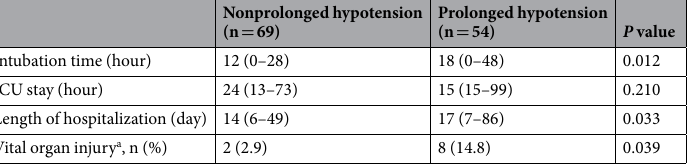
Table 3. Postoperative parameters. ICU, intensive care unit. a Vital organ injury was defined as acute kidney injury and cardiac injury.